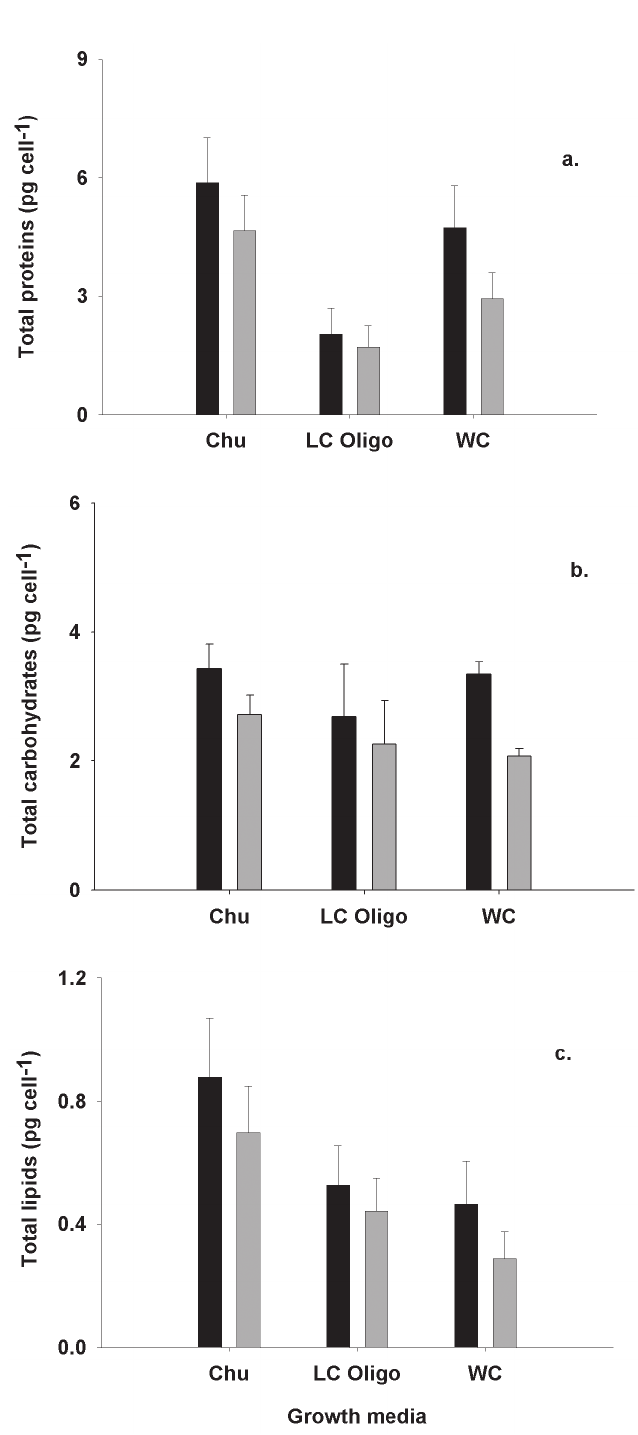
Figure 2 - Total carbohydrate (a) , total protein (b) and total lipid (c) production (black bars) and yield (gray bars) (pg.cell -1 ) of Chlorella vulgaris as a function of media type using semi continuous culture system. Error bars represent standard deviation for n = 3. Chu = Chu medium, WC = WC medium, LC Oligo = LC Oligo